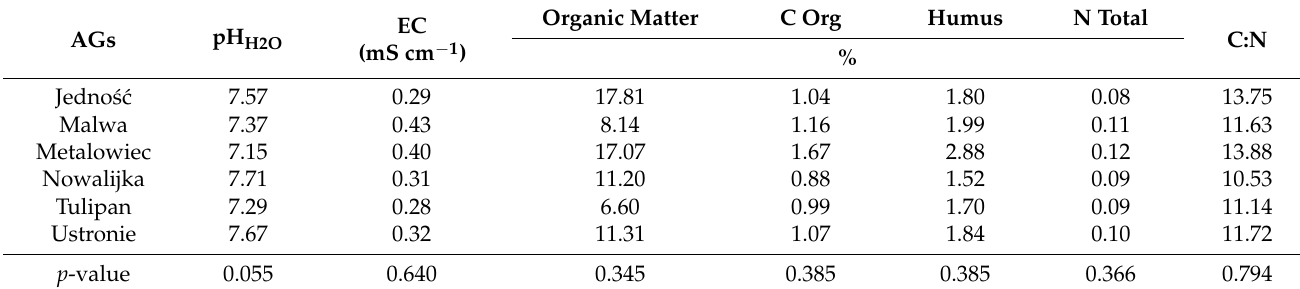
Table 4. Soil reaction, EC, content of organic matter, organic carbon, humus, total nitrogen, and the C:N ratio of six allotment gardens in Gorz ó w